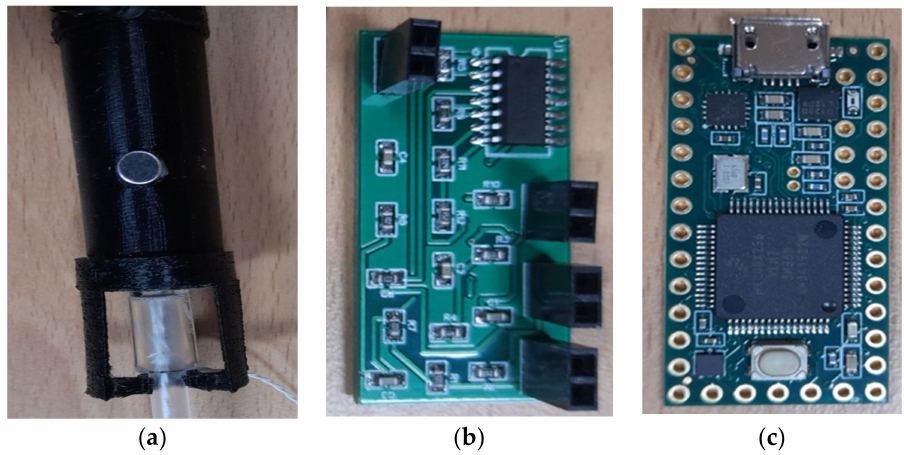
Figure 12. Different parts of the designed system. ( a ) Microphone case, ( b ) amplification circuit and ( c ) Teensy 3.2 development board.